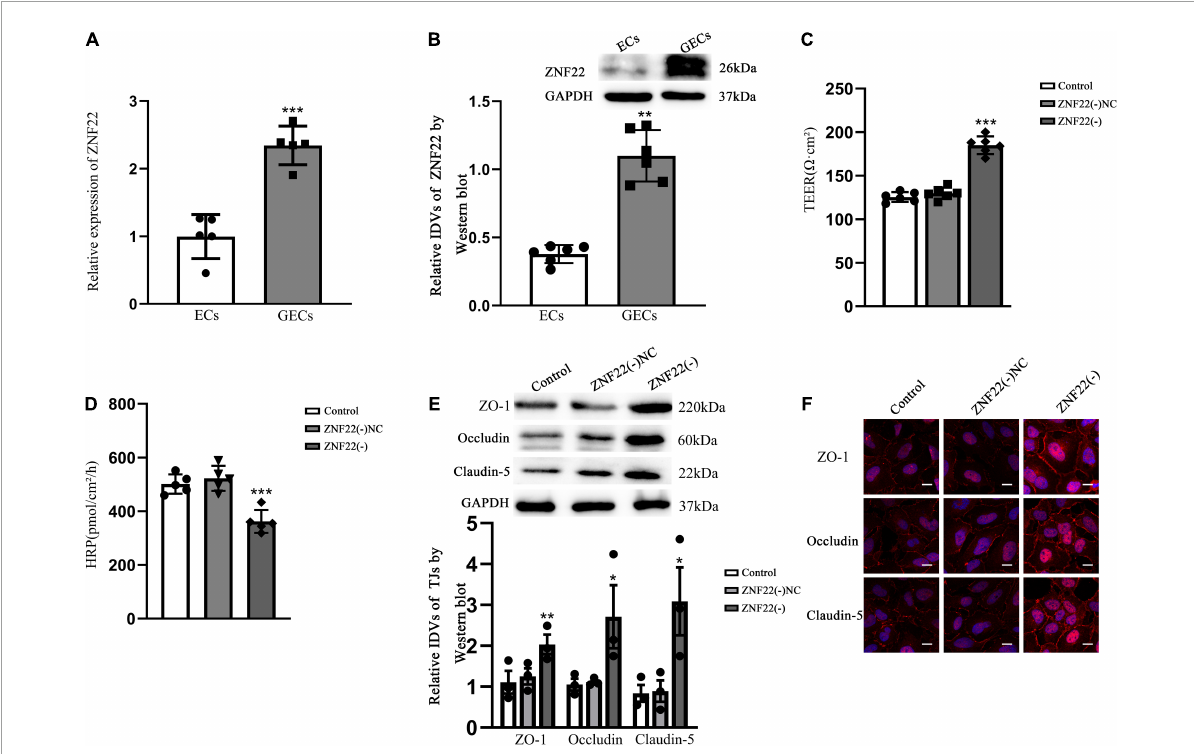
FIGURE2 Endogenous expression of ZNF22 was detected in GECs of BTB and was involved in the regulation of BTB permeability in vitro . (A) qRT-PCR was used to identify the relative expression of ZNF22 in ECs and GECs. As an endogenous control, GAPDH protein levels were measured. Data represent mean ± SD ( n = 3, each). *** p < 0.001 vs. ECs group. (B) Test for the expression of ZNF22 protein using immunoblotting. As an endogenous control, GAPDH protein levels were measured. Data represent mean ± SD ( n = 3, each). ** p < 0.01 vs. ECs group. (C) TEER values of GECs were expressed as (cid:127) cm 2 . Data were expressed as mean ± SD ( n = 3, each). *** p < 0.001 vs. ZNF22(–) NC group. (D) pmol/cm 2 /h was used to compute the HRP flow. Data were expressed as mean ± SD ( n = 3, each). *** p < 0.001 vs. ZNF22(–) NC group. (E) TJ-associated proteins ZO-1, Occludin, and Claudin-5 in GECs were examined by protein blotting. As an endogenous control, GAPDH protein levels were measured. Data were expressed as. * p < 0.05 and ** p < 0.01 vs. ZNF22(–) NC group. (F) ZO-1, Occludin, and Claudin-5 immunofluorescent localization in GECs. ZO-1, Occludin, and Claudin-5 all were colored red using fluorescent secondary antibodies, and DAPI was used to mark the nuclei. Three separate experiments were shown by the photographs. Scale bar = 20 µ